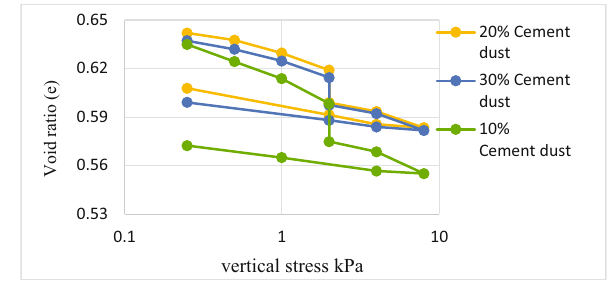
Figure 6: Collapse test results for soil treated with ( 6% ) powder Sodium metasilicate.